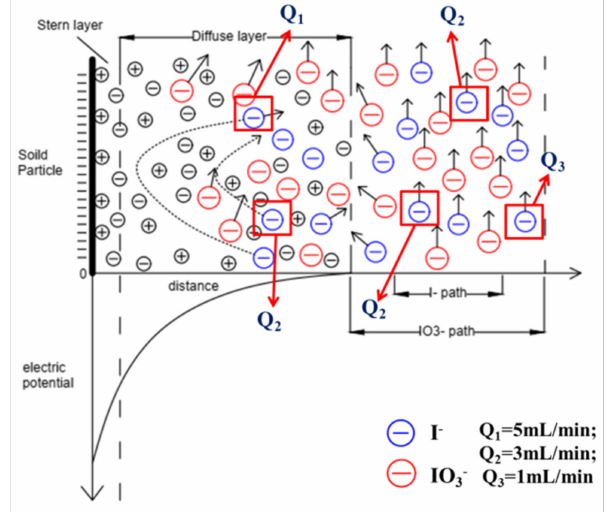
Figure 7. Schematic model of I − and IO 3 − transport at various flow